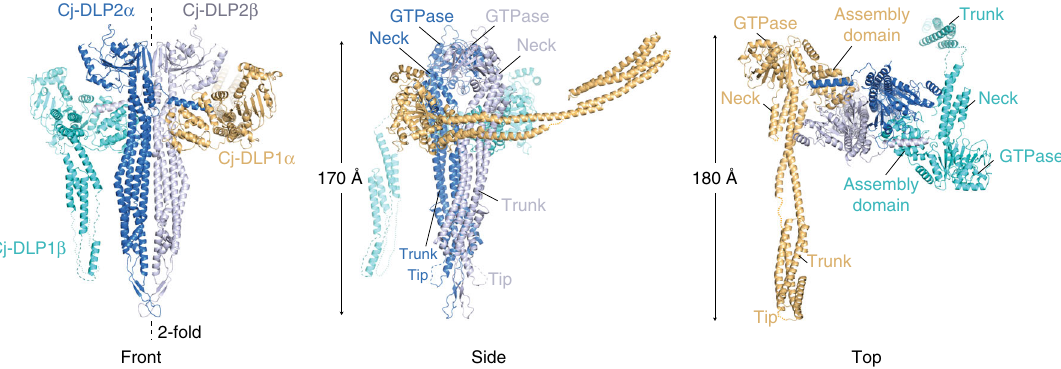
Fig. 2 The crystal structure of Cj-DLP1/2 tetramer in the apo state. Cj-DLP1 and Cj-DLP2 exist as a tetrameric oligomer with 2:2 stoichiometry within the asymmetric unit. Cj-DLP2 forms a central back-to-back dimer fl anked on each side by Cj-DLP1 subunits. Cj-DLP1 subunits are diametrically opposed with trunk domains observed in radically different conformations. Tip region represents equivalent position of the BDLP lipid binding paddle 9